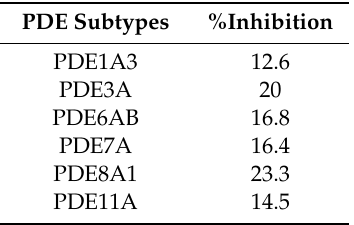
Table 5. Percentage inhibition of PDE sub-types by BIT1 (measured at 1 µ